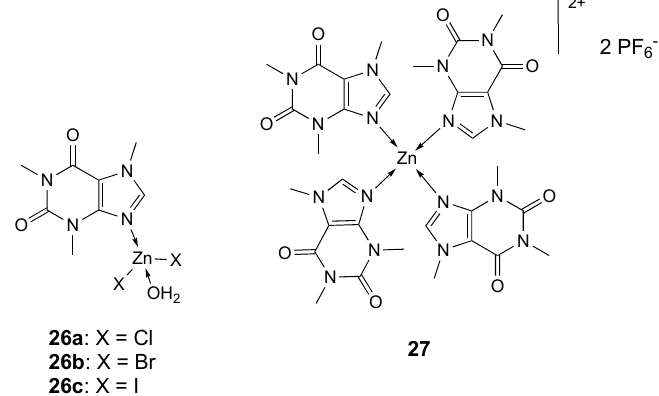
Figure 15. Structure of the zinc complexes 26a – c and 27 .